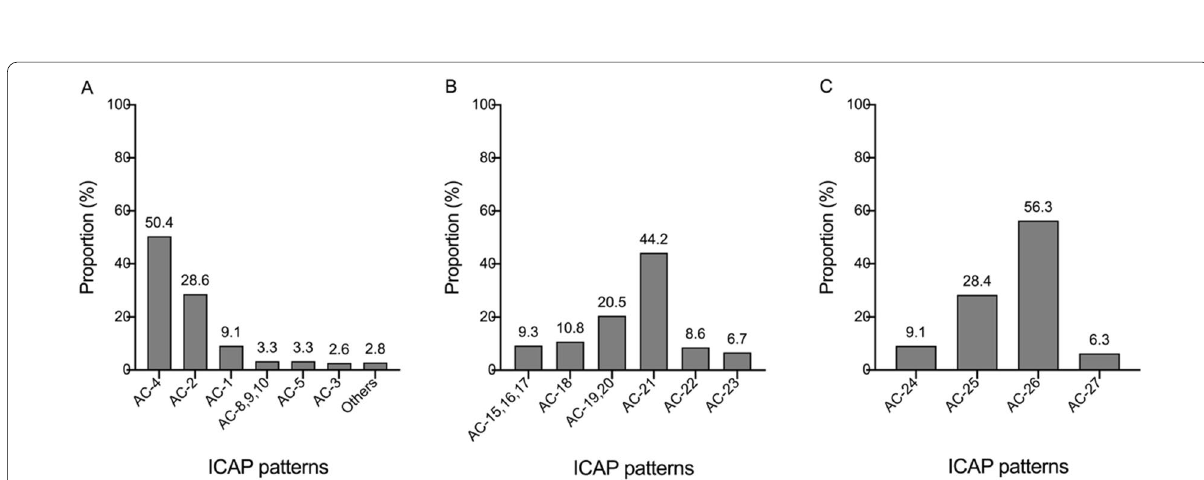
Fig. 3 HEp-2 IIFA–Fluorescence staining patterns according to cellular domains and ICAP codes in 9218 serum samples analyzed from January to June 2017. A ICAP nuclear patterns; B ICAP cytoplasmic patterns; C ICAP mitotic patterns. BAC-3: nuclear quasi -homogeneous (n nuclear reticular coarse speckled (n 103) and mixed patterns (n 1005) not = =